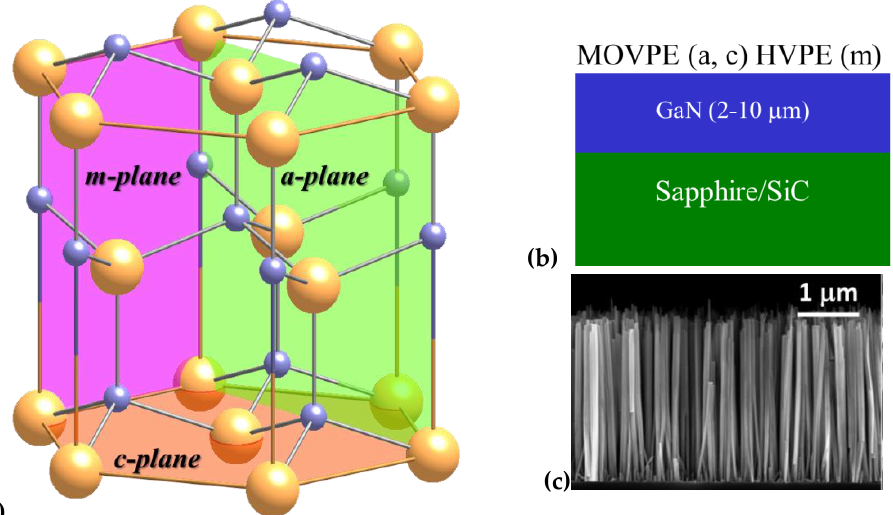
Figure 1. ( a ) Wurtzite GaN structure and major crystallographic planes. ( b ) Schematic sample structures with a- and c-plane GaN grown using metal-organic vapour-phase epitaxy (MOVPE) and the m-plane sample using hydride vapour-phase epitaxy (HVPE). ( c ) Scanning electron microscopy (SEM) image of the molecular beam epitaxy (MBE) grown nanowires (NWs). NWs were grown using molecular beam epitaxy (MBE) on silicon substrates. Figure 1c shows a typical scanning electron microscopy (SEM) image of an as-grown sample. The NWs were grown vertically aligned along the c-axis and show m-plane side facets [46]. They had typical lengths of 2.5 µ m and the width of the NWs was around 50–100 nm. As an example of optical doping, NWs, as well as thin-film c-plane GaN, were